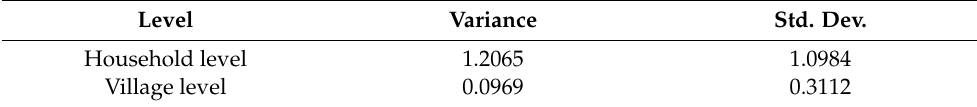
Table 6. The random effects of the HSTRM